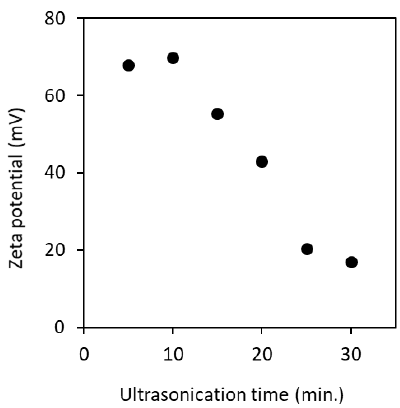
Figure 7. Zeta potential of partially deacetylated chitin nanofiber as a function of ultrasonication